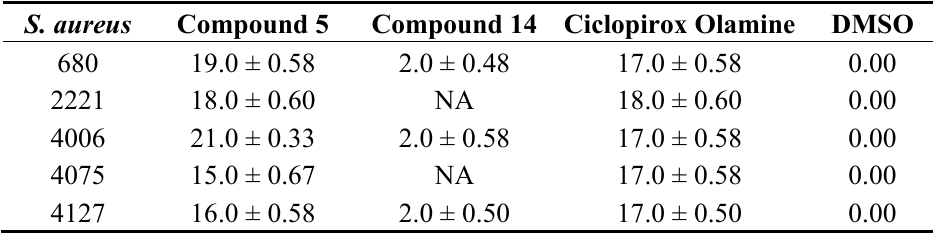
Table 1. Antibacterial activity of compounds 5 and 14 ( inhibition zones in mm ± SD).